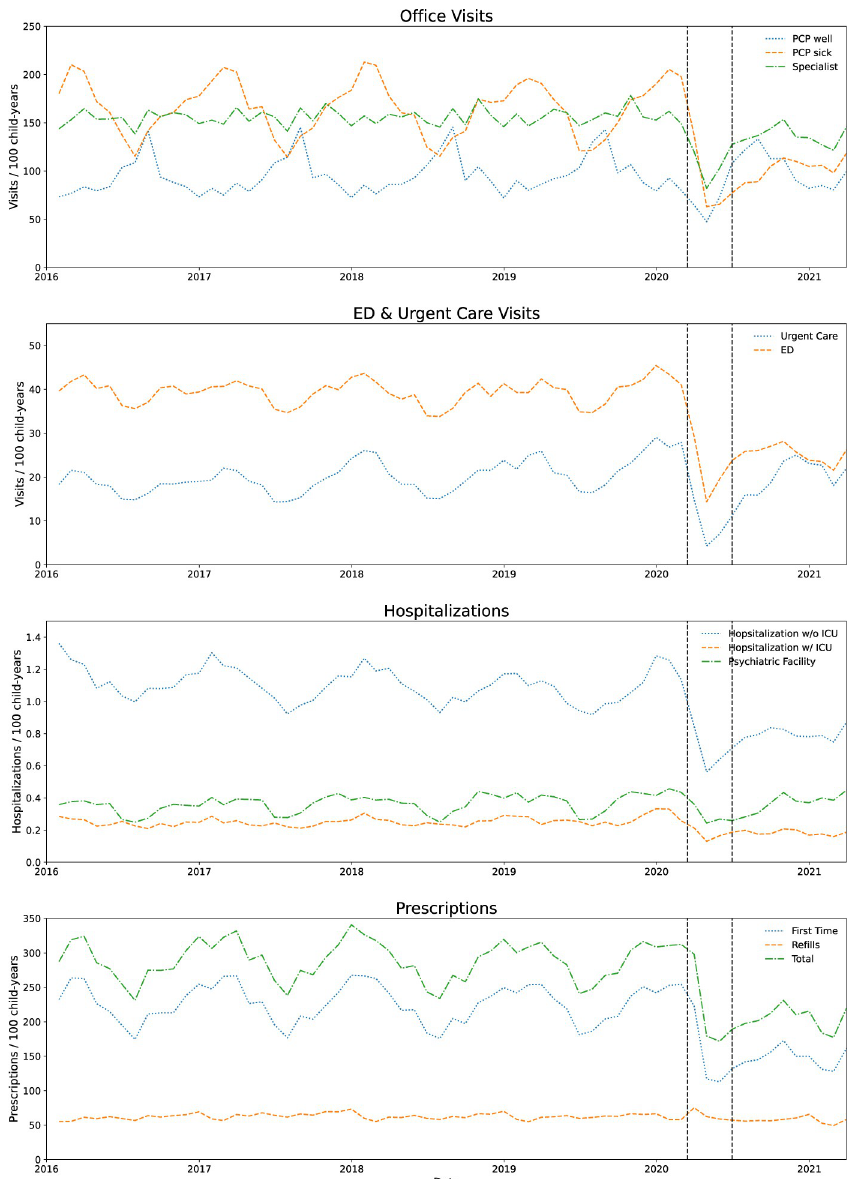
Fig 1. Time series depicting trends in utilization and prescriptions per 100 child-years over the study period. Dotted vertical lines represent the starts of the early pandemic (mid-March) and mid-pandemic (mid-June).